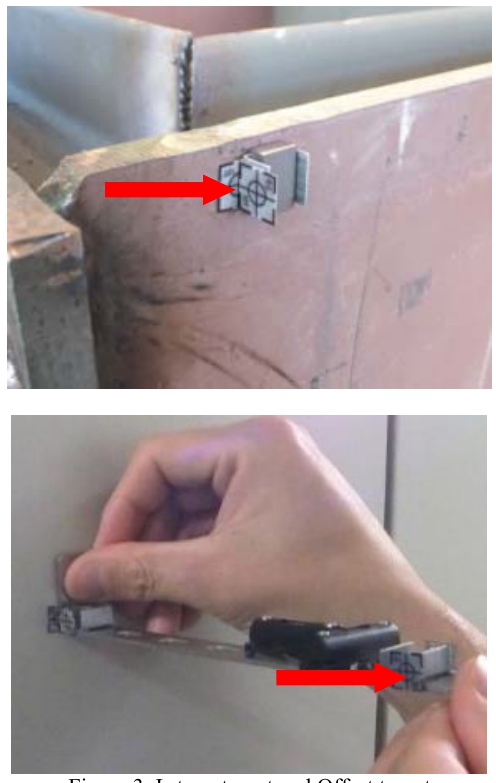
Figure 3. L-type target and Offset target